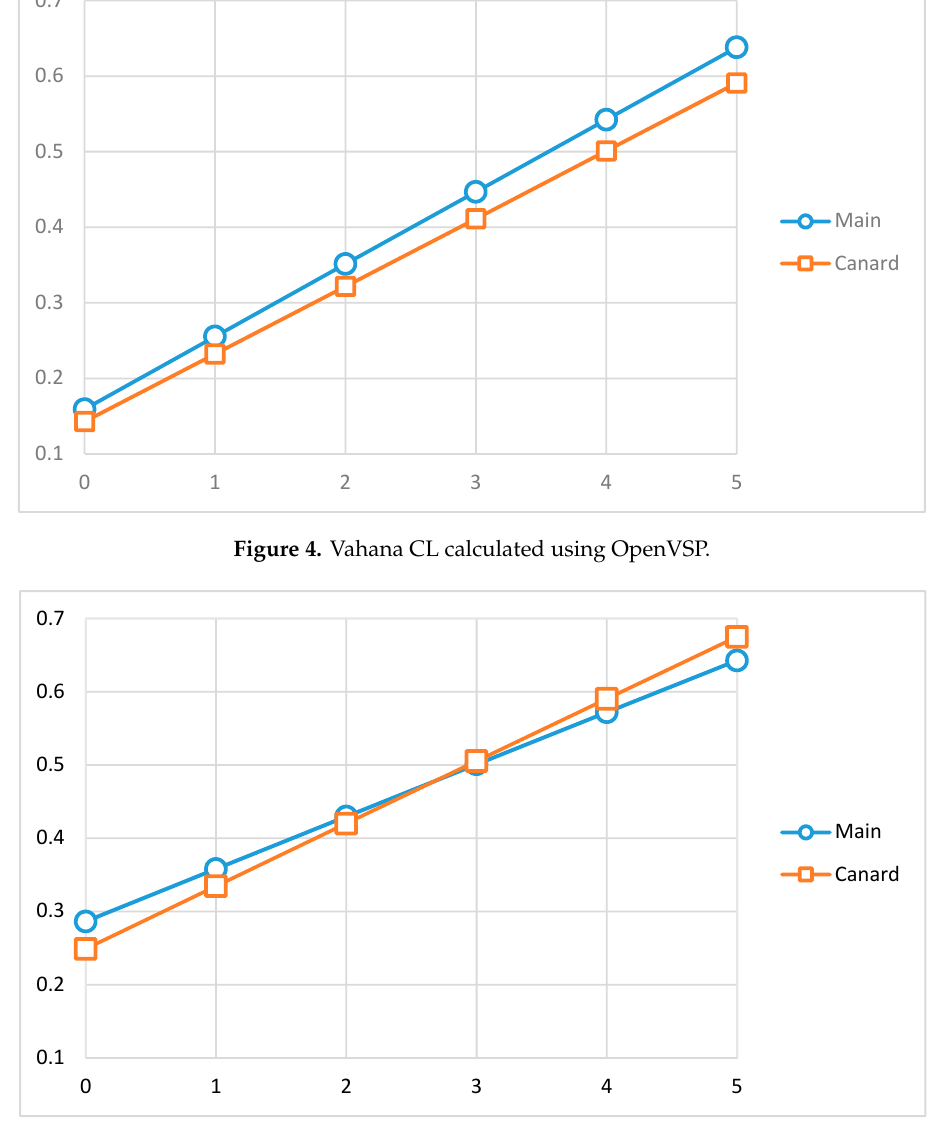
Figure 5. Vahana C L calculated using XFLR5. Table 11. Vahana induced